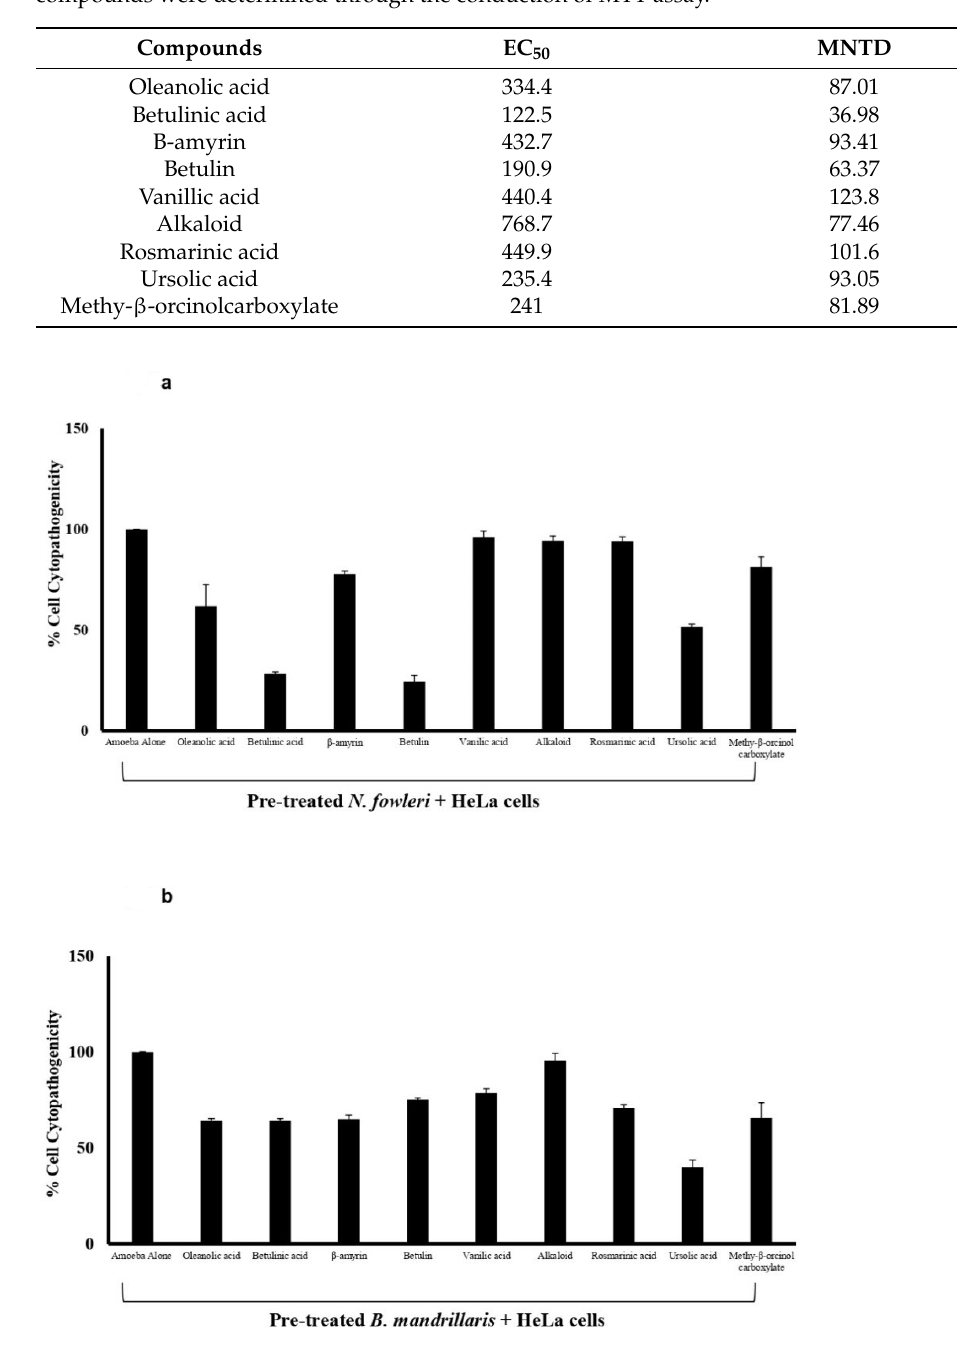
Figure 3. The plant-based compounds reduced amoebae-mediated host cell death. ( a ) The compounds reduced B. mandrillaris mediated cytotoxicity against human cells and ( b ) against N. fowleri mediated cytotoxicity against human cells. In short, 2 × 10 5 amoebae were incubated with 100 µg/mL of the compounds for 2 h. After the 2-h incubation period was complete, the pre-treated amoebae were transferred to the HeLa cells and incubated overnight. Overall, the drugs are capable of inhibiting amoeba-meditated host cytotoxicity when compared to the amoeba alone. The data is illustrative of several independent experiments and presented as the mean ± standard error. The Y-axis error bars are indicative of standard error of the data depicted in the graphs. * corresponds to p < 0.05.